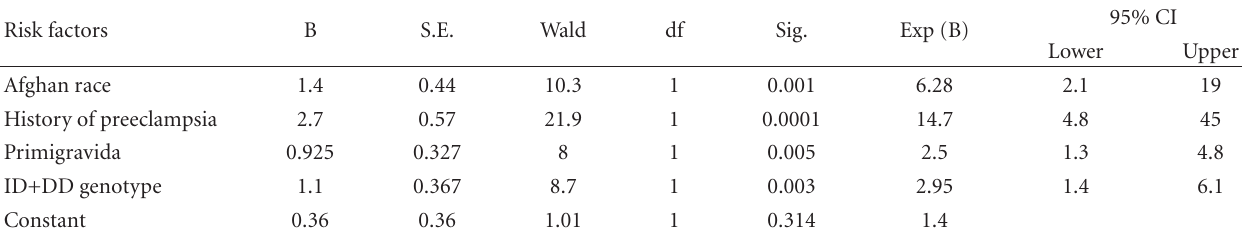
Table 3: Multiple logistic regression analysis with forward stepwise selection